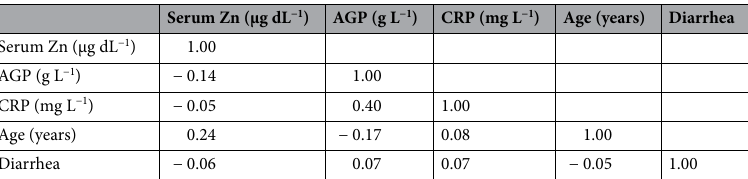
Table 3. Spearman’s rank correlations between serum Zn, inflammation biomarkers, the incidence of diarrhea, and age of all demographic groups. AGP α-1-glycoprotein concentration, CRP C-reactive protein